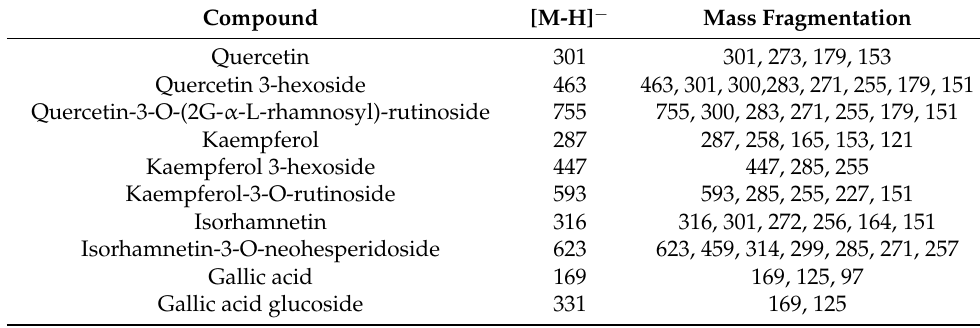
Table 1. Identification of flavonoids and tannins in Euphorbia supina Raf Extracts (ESR-Ex) (LC- MS